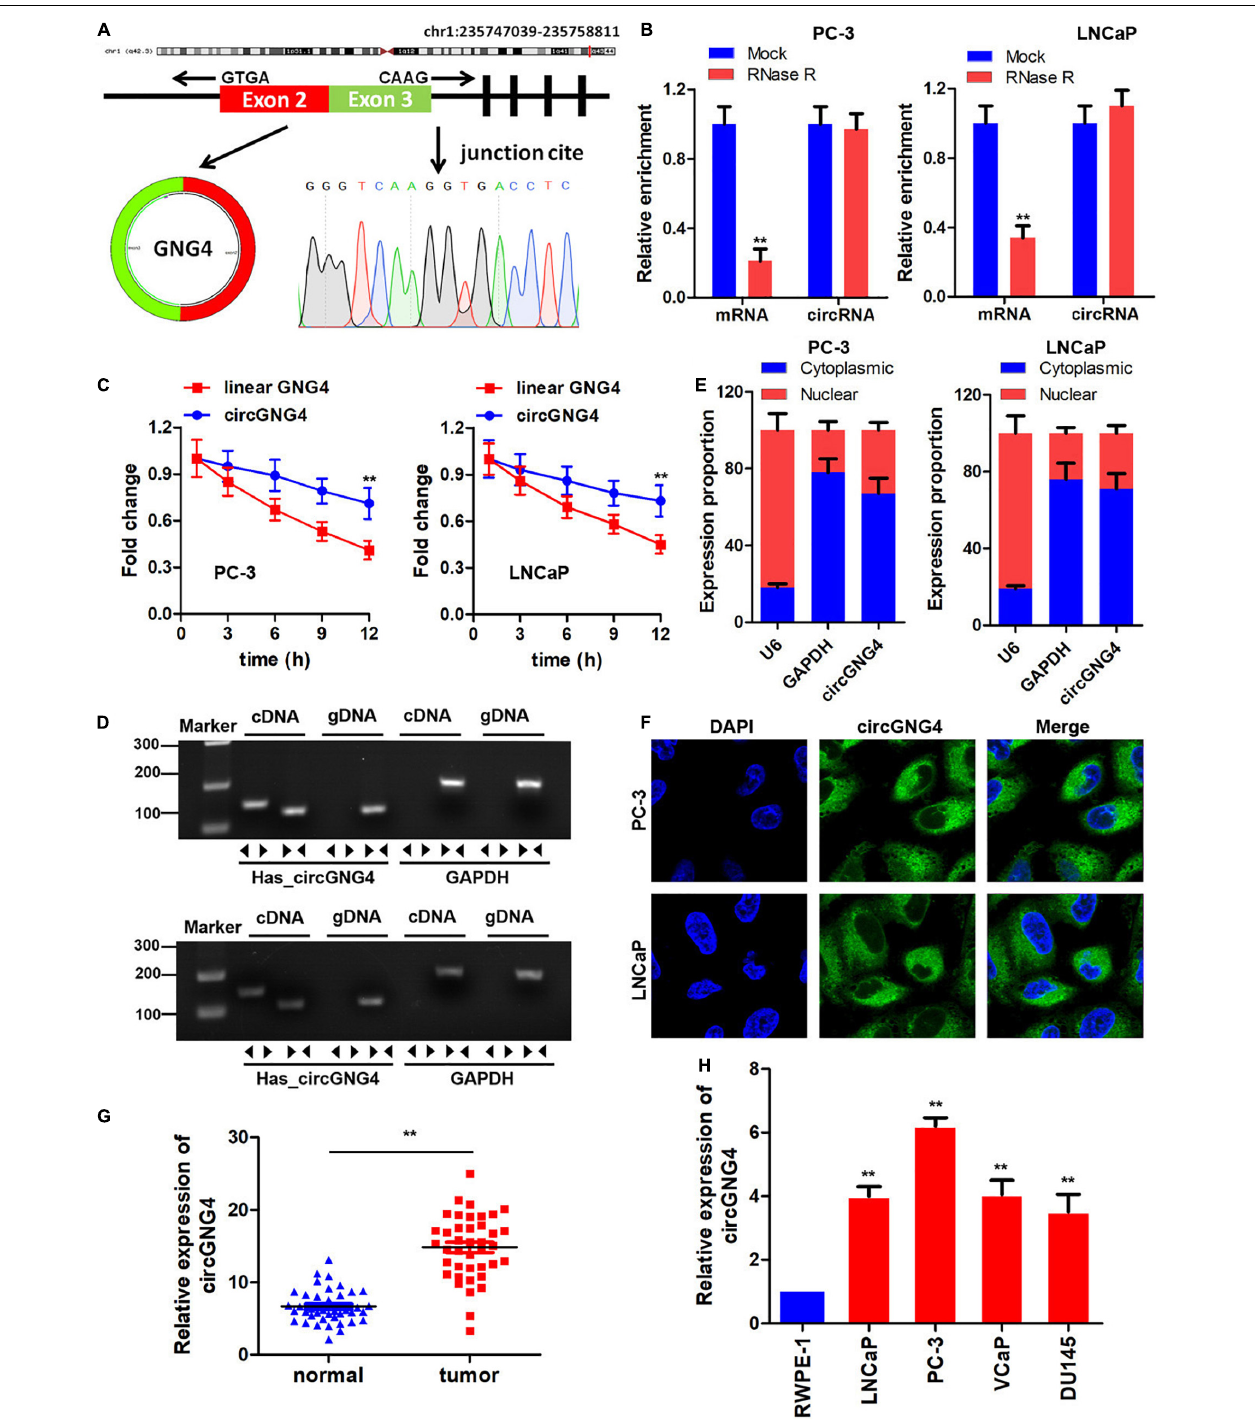
FIGURE 1 | Study on circGNG4 cyclization mechanism. (A) The circRNA cyclization mechanism was spliced by exons 2 and 3, and the sequence was verified by sanger sequencing. (B) After RNase R treatment, linear and circRNA expression was detected to demonstrate stability. (C) After actinomycin treatment, the half-life of linear and circular GNG4 was detected. (D) Convergent and divergent primers were designed, and PCR was performed using cDNA and genomic DNA as the template for verification. (E) The nucleus and cytoplasm of cells was separated and quantitative PCR was used to detect the expression of circGNG4 in the nucleus and cytoplasm. (F) Fluorescence in situ hybridization was performed to detect the intracellular localization of circGNG4. (H) Expression of circGNG4 was detected in tumor tissues. (G) circGNG4 expression was detected in cell lines. ** p < 0.01 vs. mock, linear GNG4, normal or RWPE-1 group. circRNA/circ, circular RNA; GNG4, G protein subunit γ